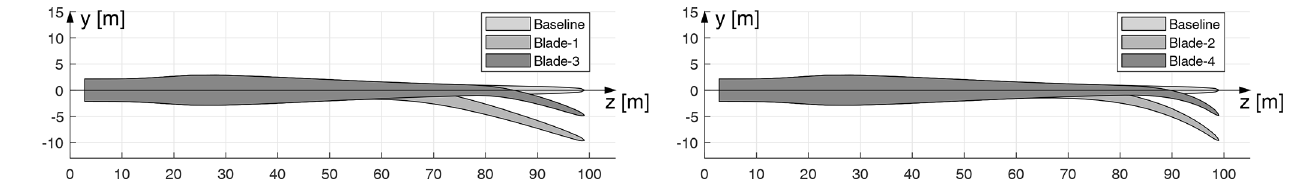
Figure 7. The top view of the backward swept blades Blade-1 to Blade-4 together with the baseline straight blade.